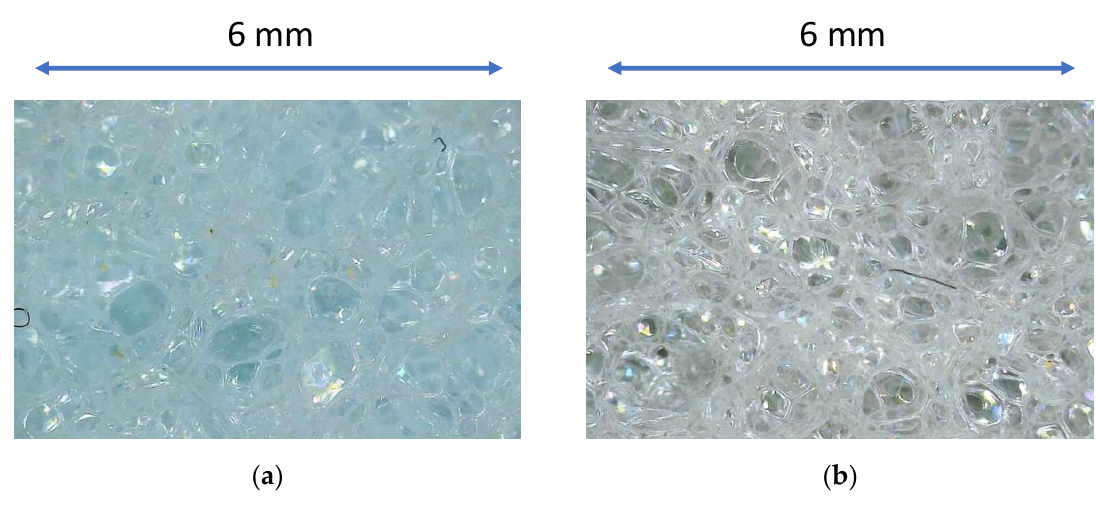
Figure 1. Micrographs of the blue ( a ) and grey ( b ) foams.